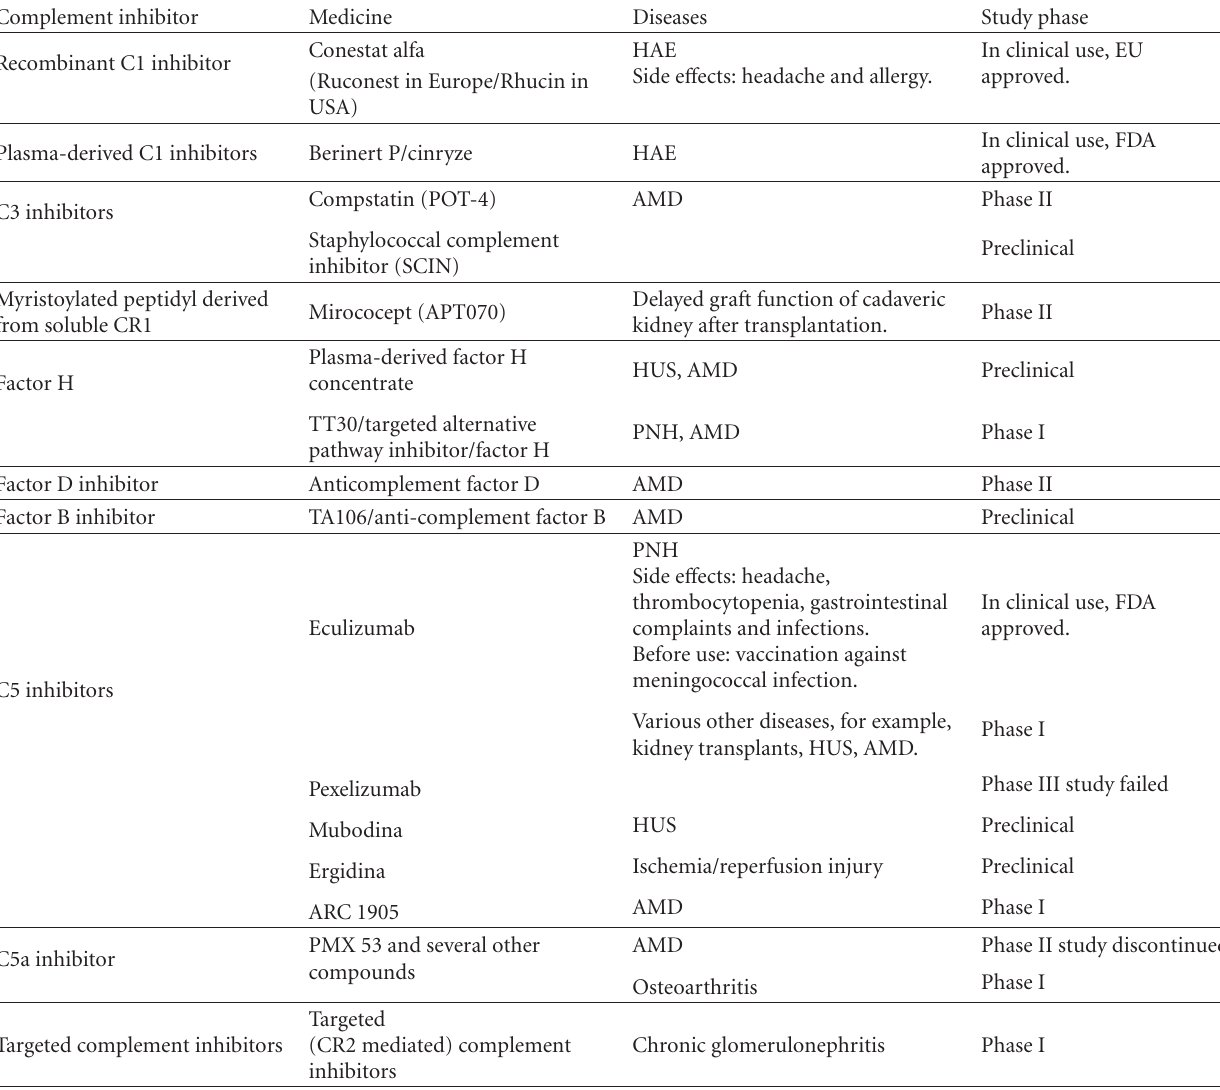
Table 1: An overview of (pre)clinical complement